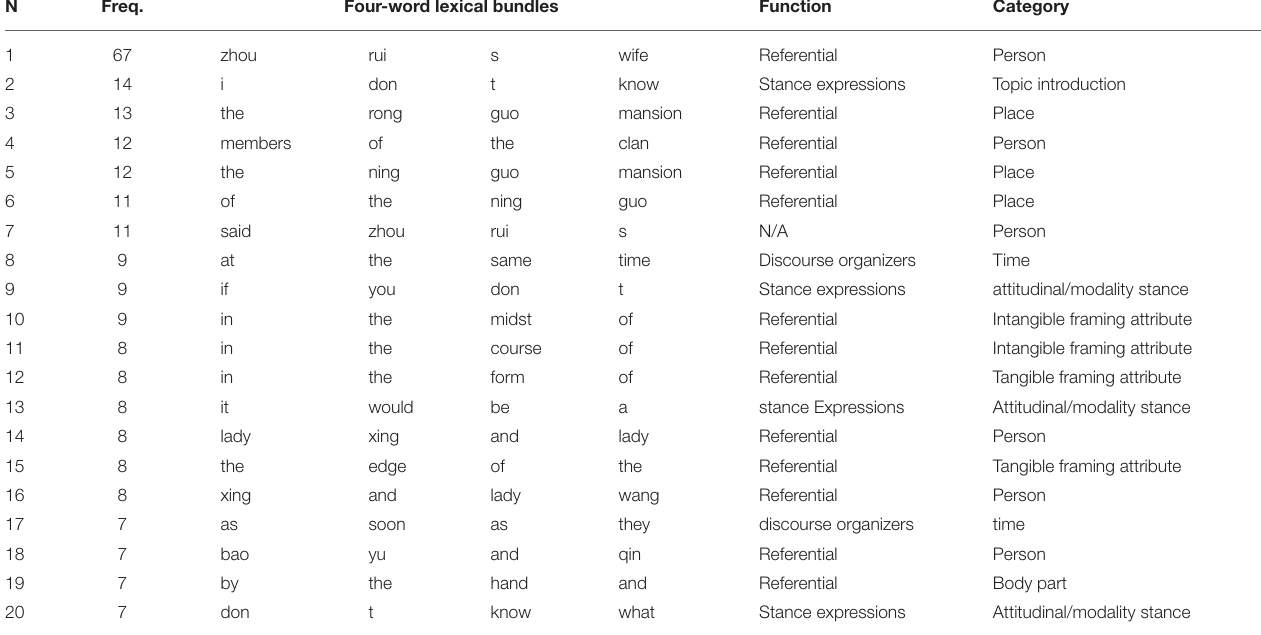
TABLE 4 | Top 20 most frequent four-word lexical bundles in Hawkes.